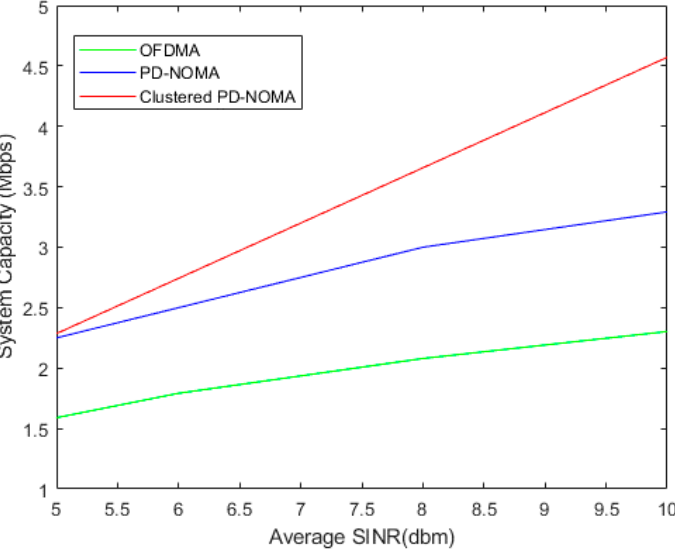
Figure 9. System capacity vs. average SINR.